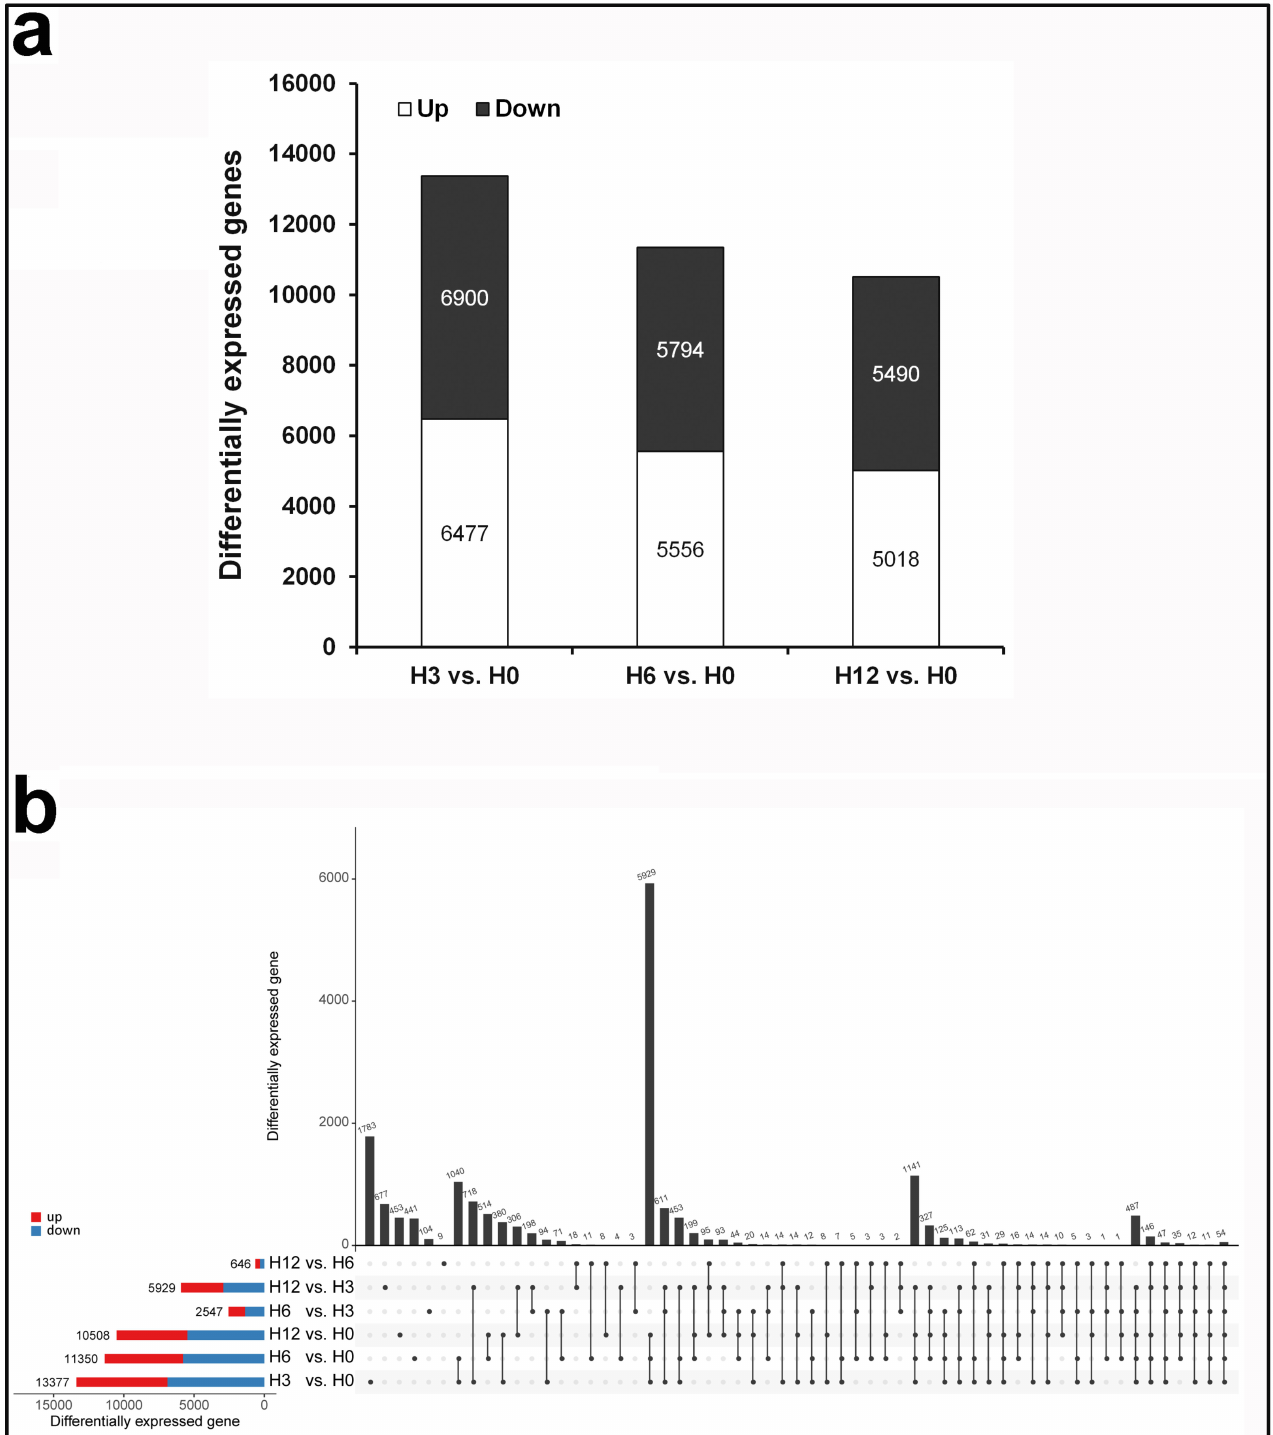
Figure 2. Multiple comparisons of DEG datasets. ( a ) Number of DEGs per dataset. Bars represent up- (white) and downregulated (black) genes in the three pairwise comparisons. ( b ) The UpSet R plot showing numbers of DEGs in each set and each